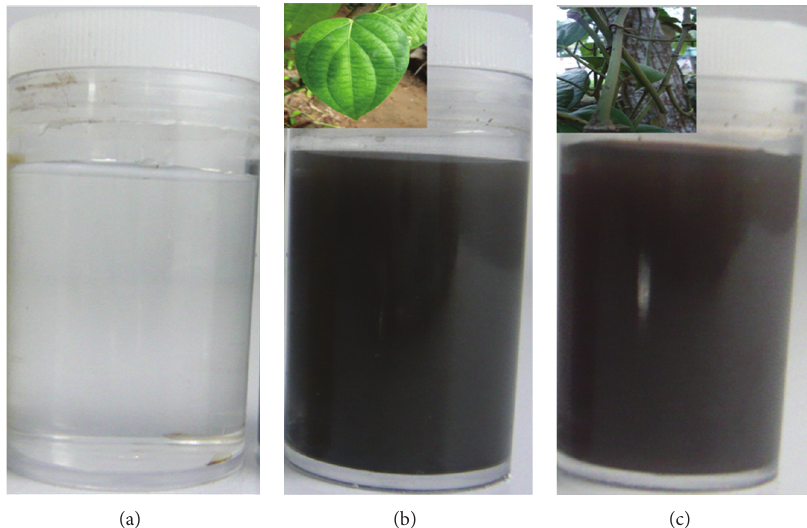
Figure 2: Visual observation of synthesis of silver nanoparticles before (a) and after addition of leaf (b) and stem (c) extract of Piper nigrum with silver nitrate solution. Inset of (b) and (c) shows Piper nigrum leaf and stem, respectively.